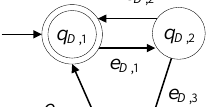
G . Figure 4. State diagram of G D . D